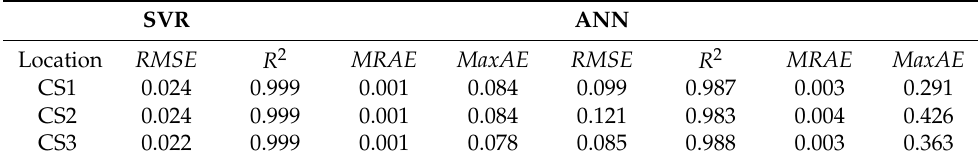
Table 3. Emulator (with four inputs) performance on test set.